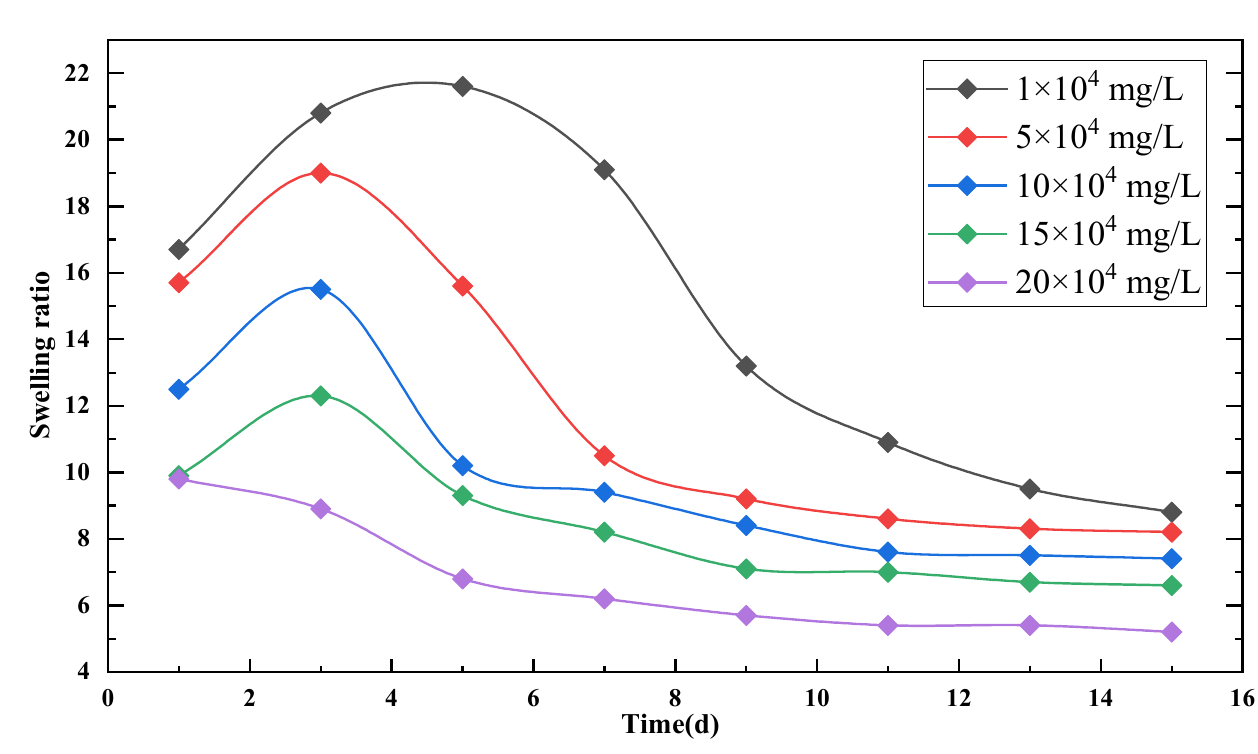
Figure 7. Influence of mineralization degree on swelling property at 120 °C .